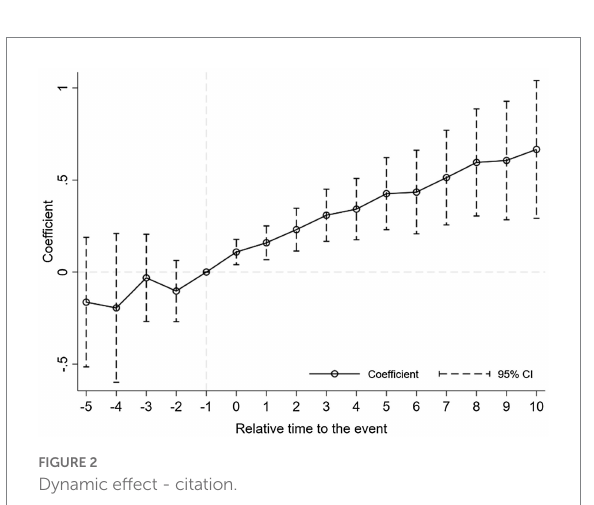
FIGURE 2 Dynamic effect -